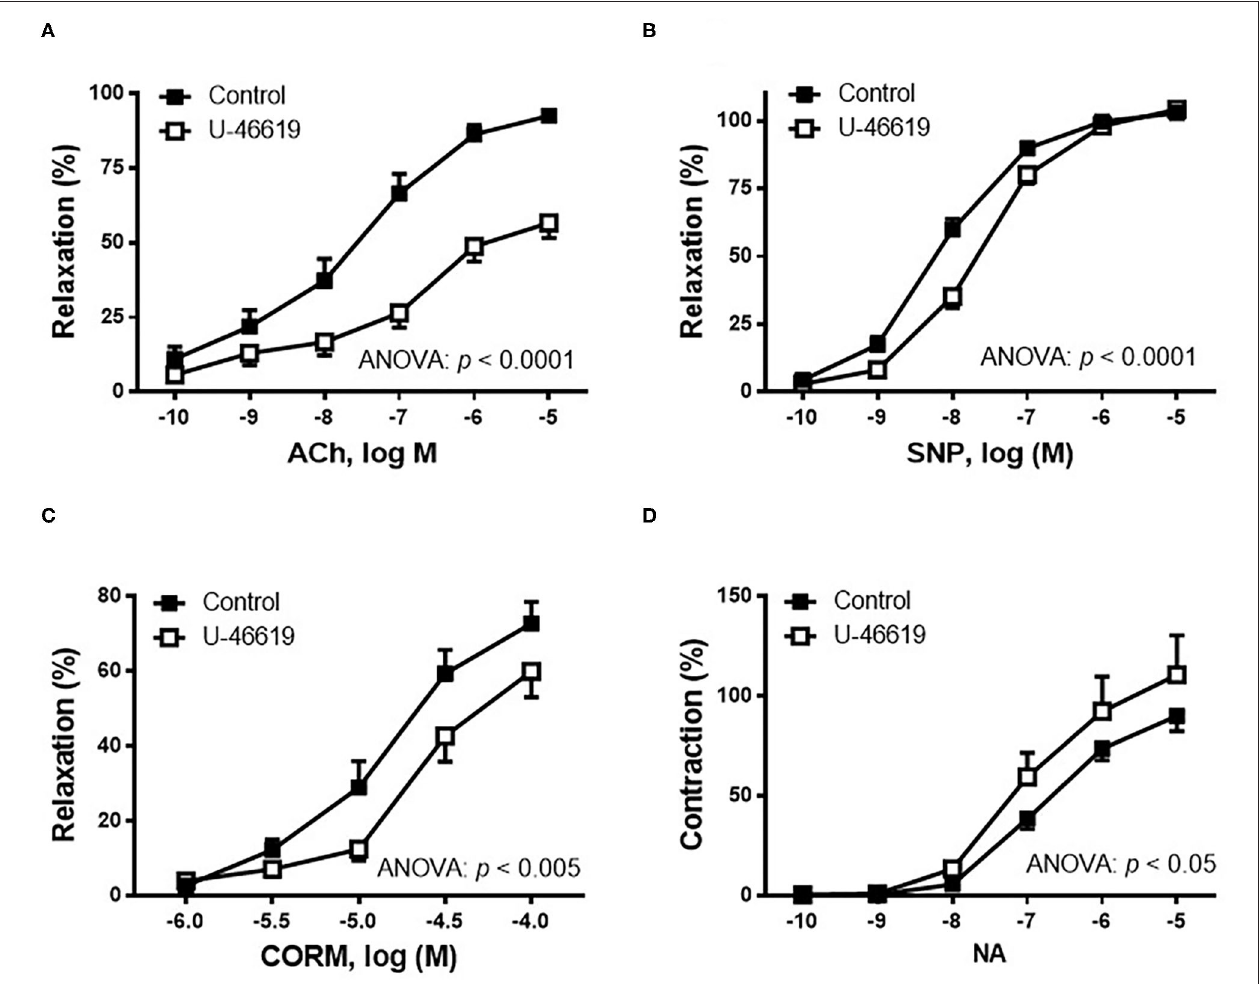
FIGURE 2 | Effect of the non-hydrolyzable mimetic of thromboxane A 2 (TXA 2 ), U-46619 (1nM), on the concentration–response curves to (A) acetylcholine (ACh), (B) sodium nitroprusside (SNP), (C) carbon monoxide-releasing molecule (CORM), and (D) noradrenaline (NA) in aortic segments of male rats. Results (mean ± SEM) are represented for the vasodilatory responses as percentage of the inhibition of the contraction elicited by 0.1 µ M of noradrenaline; for the NA-induced vasoconstriction, the response was represented as percentage of the previous contraction induced by KCl (75mM). Number of animals: 4–5. The statistical significance is indicated in the corresponding